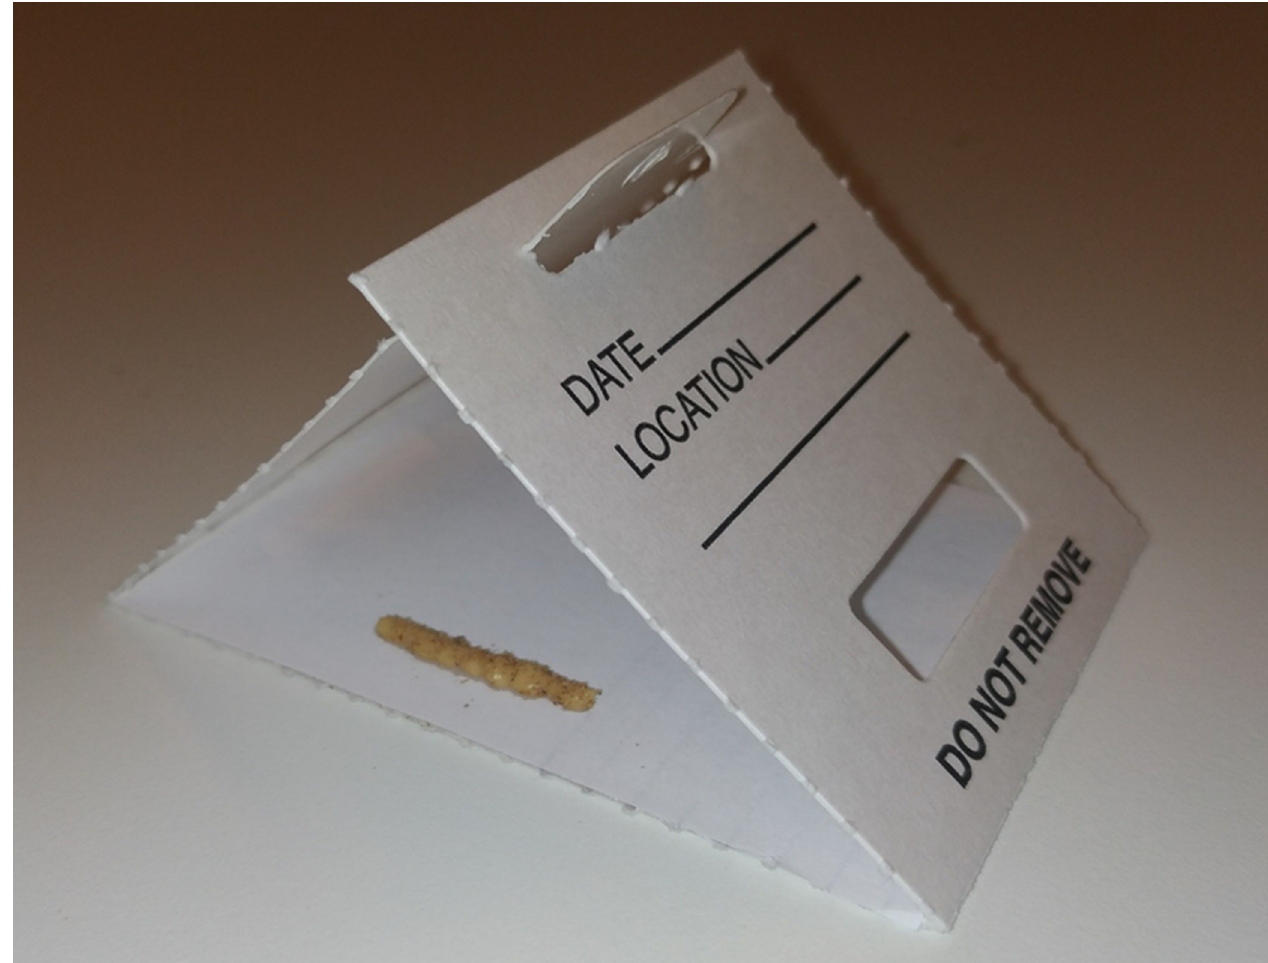
Fig 2. Bait station for Ctenolepisma longicaudatum made from a deactivated delta trap. Bait is sprinkled with cricket powder to act as an attractant.